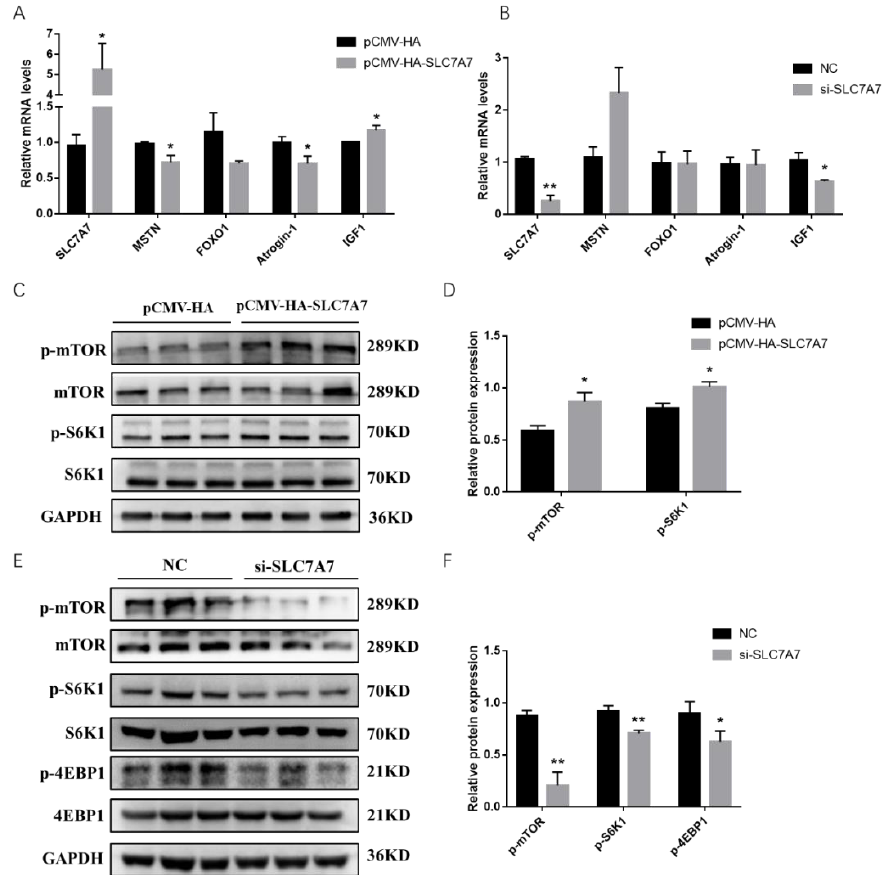
Figure 6. Overexpression and interference of SLC7A7 in PSCs affect expression of genes involved in protein synthesis and mTOR signaling pathway. ( A ) The mRNA expression level of SLC7A7 , MSTN , FOXO1 , Atrogin-1 and IFG1 after overexpression of SLC7A7 ; ( B ) the mRNA expression level of SLC7A7 , MSTN , FOXO1 , Atrogin-1 and IFG1 after interference with SLC7A7 ; ( C ) the phosphorylation level of mTOR and S6K1 after overexpression of SLC7A7 ; ( D ) quantification of Western blotting after overexpression of SLC7A7 ; ( E ) the phosphorylation level of mTOR, S6K1 and 4EBP1 after interference with SLC7A7 ; ( F ) quantification of Western blotting after interference with SLC7A7 . *, ** indicate significant difference at p < 0.05 and p < 0.01, respectively.